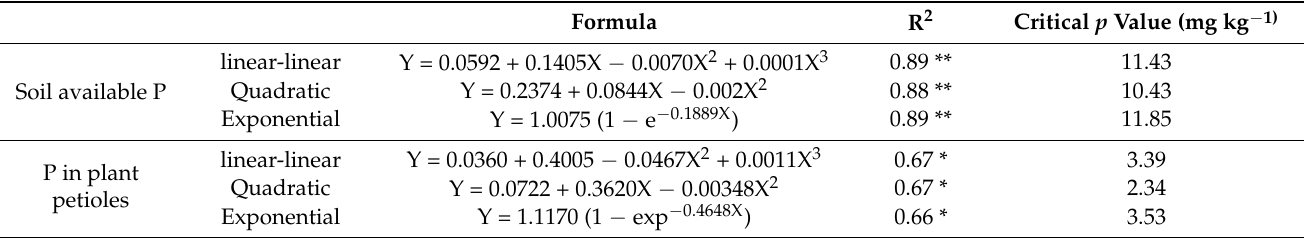
Table 5. The relationship between mango yield, soil P and petiole-P fitted by the linear-linear, quadratic, and exponential models under four years (2018–2021). *, ** significant at p < 0.05 and p < 0.01. Number of samples is